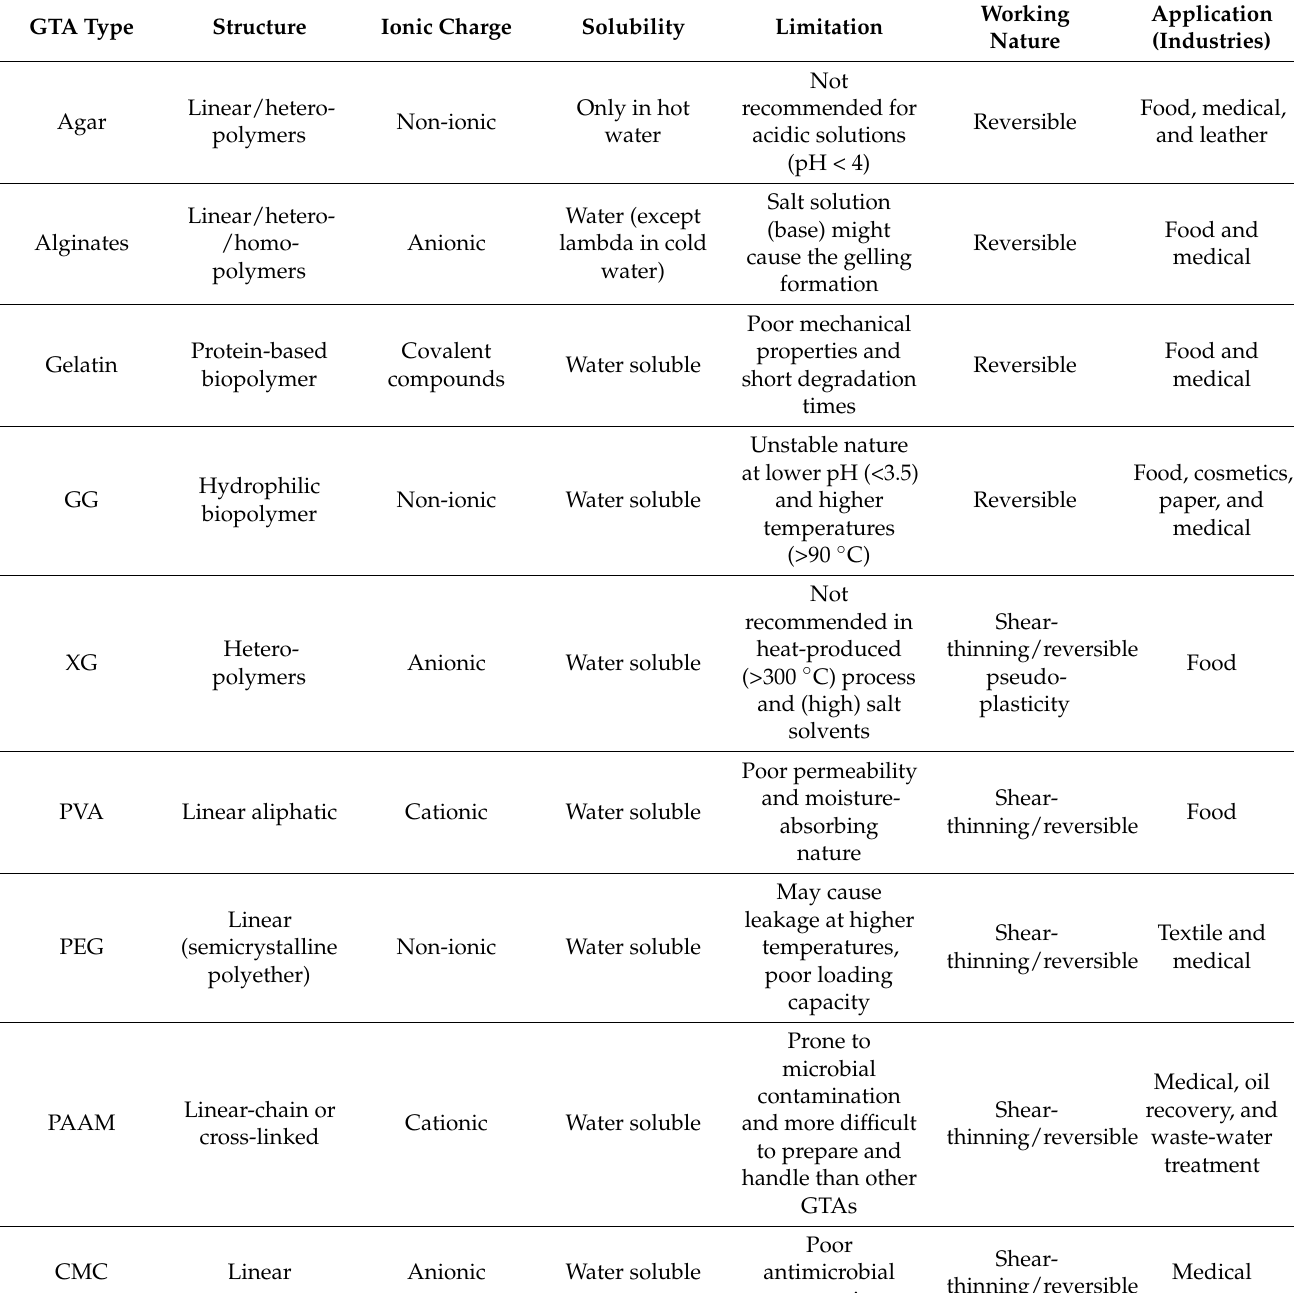
Table 1. General properties of available GTAs from the existing studies